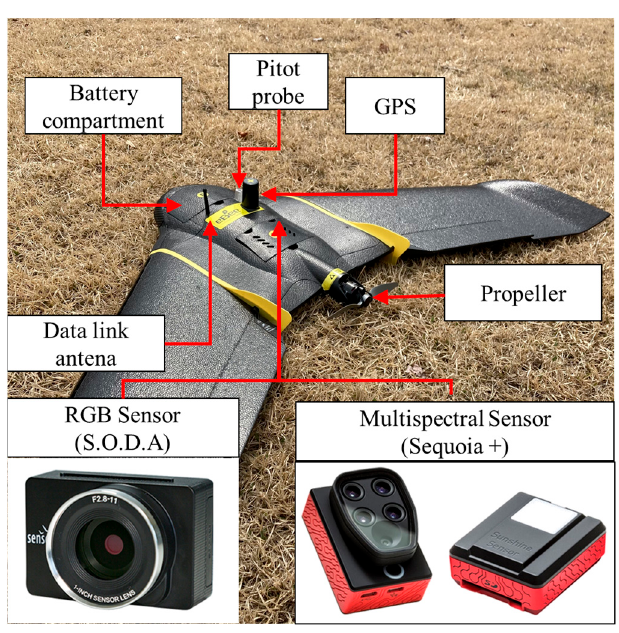
Figure 5. Configuration of fixed-wing UAVs (eBee Plus, Sensefly) and onboard devices used to collect imagery in a wide area.